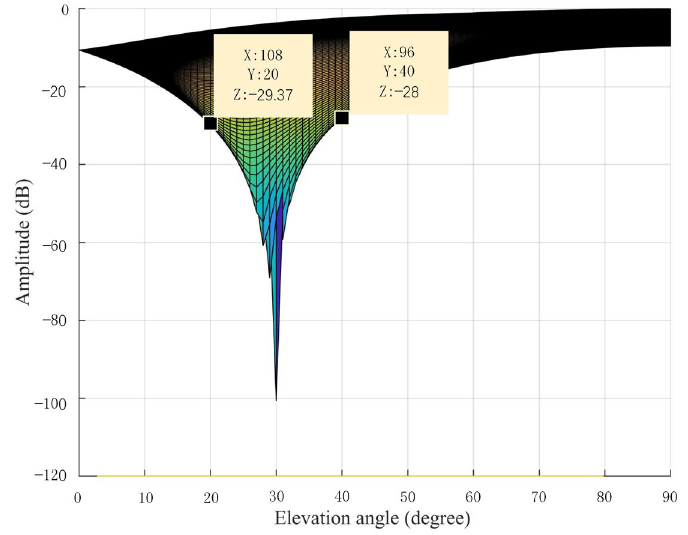
Figure 5. Zero airspace scanning beamwidth.